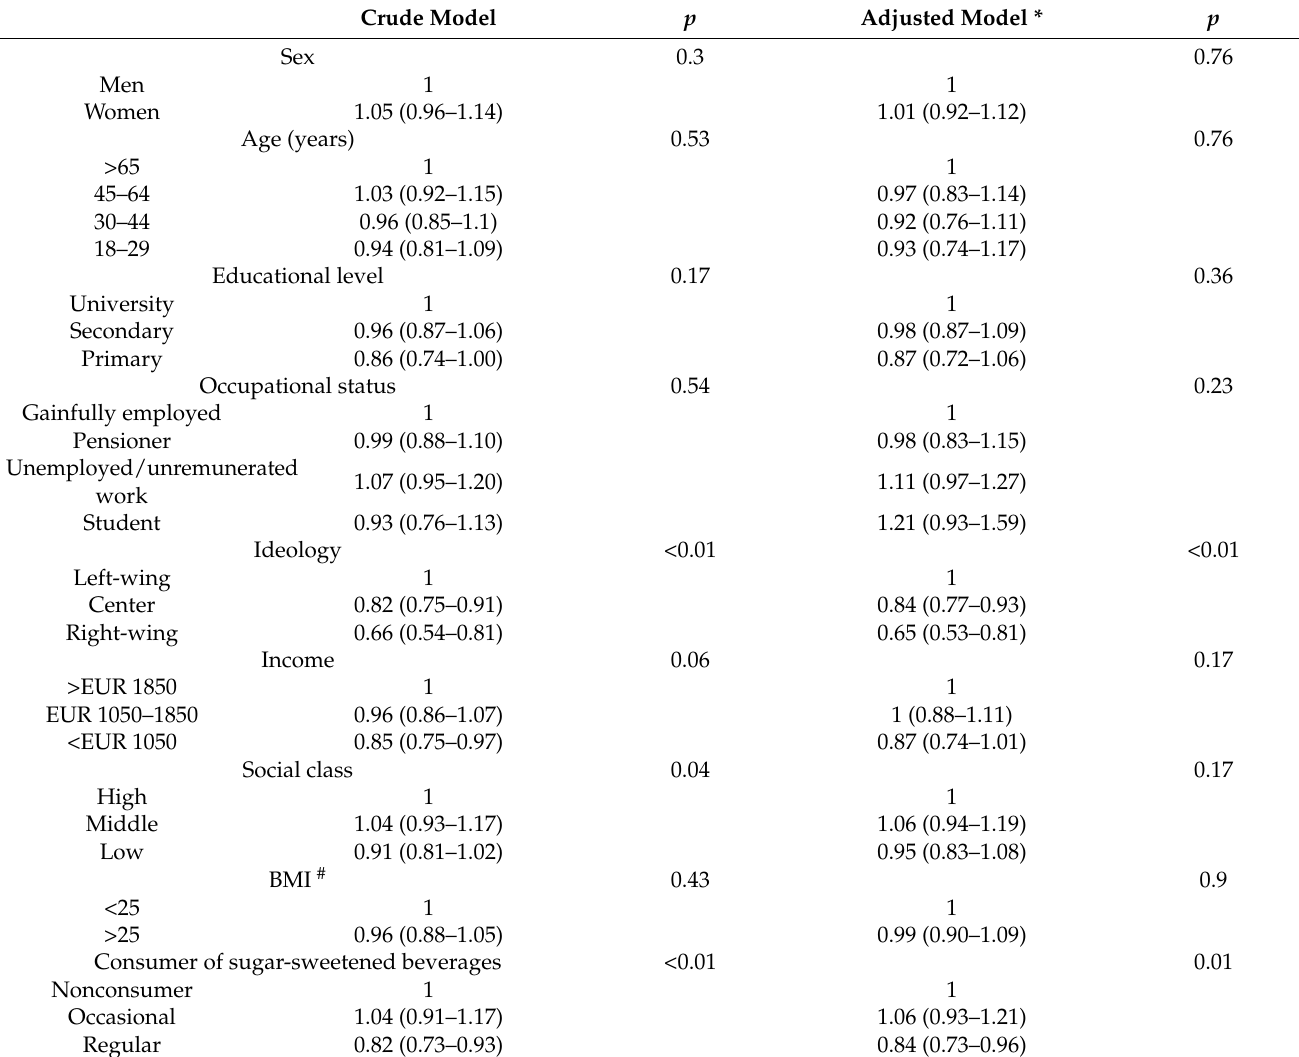
Table 4. Prevalence ratios (95% CI) of support for a tax on sugar-sweetened beverages obtained with Poisson regression